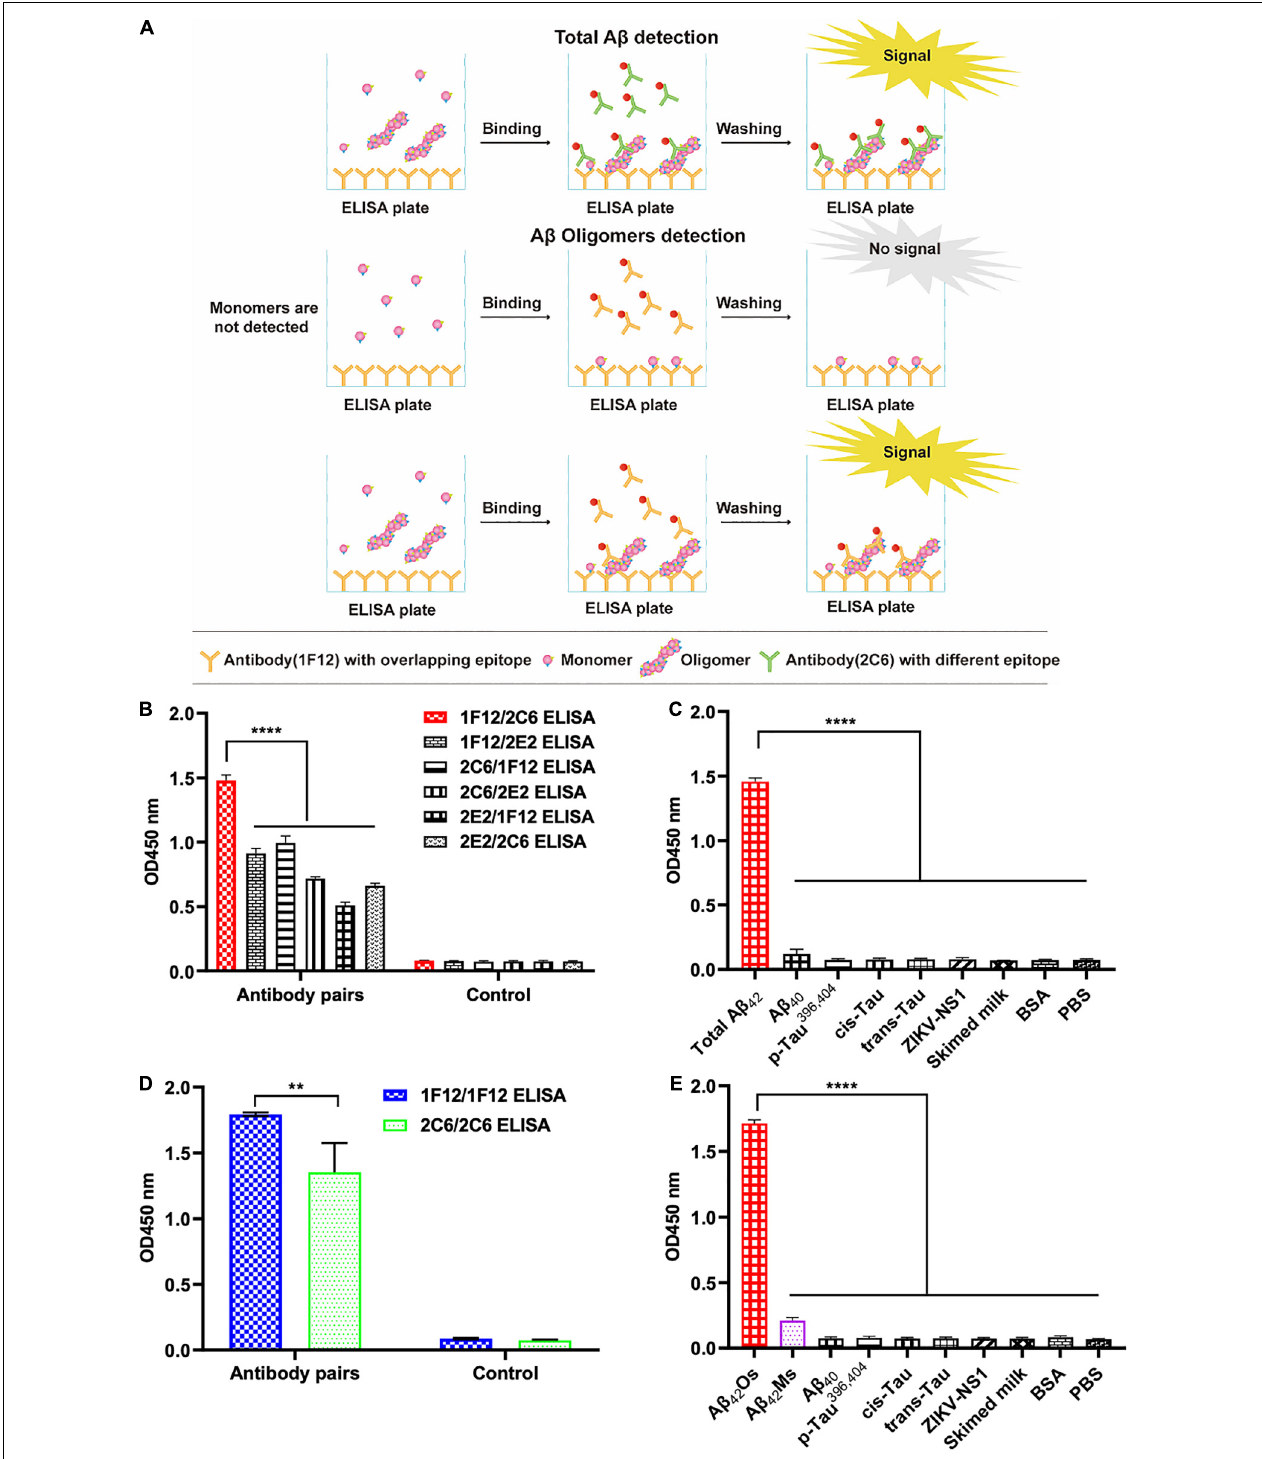
FIGURE 2 | Screening of preferred antibody pairs 1F12/2C6 and 1F12/1F12 against A β 42 Ms and A β 42 Os. (A) Schematic representation of 1F12/2C6, 1F12/1F12 ELISA to detect total A β 42 , A β 42 Os, respectively. (B) Preferred antibody pairs were screened for the detection of total A β 42 . (C) The specificity assay of 1F12/2C6 ELISA for total A β 42 detection. (D) Preferred antibody pairs were screened for the detection of A β 42 Os. (E) The specificity assay of 1F12/1F12 ELISA for A β 42 Os detection. Data are presented as means ± SEM. Two-way analysis of variance (ANOVA) was used for (B,D) and One-way analysis of variance (ANOVA) was used for (C,E) . Statistical significance is indicated in the figures by ** p < 0.01 and **** p <